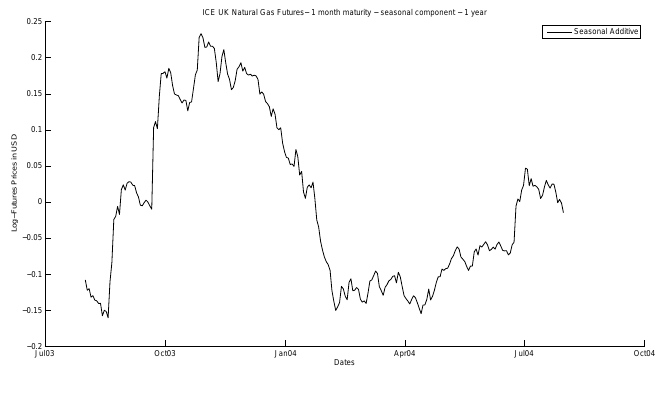
Figure 3. ICE U.K. Natural Gas Futures: seasonal additive shown for one year for the one-month rolling future.